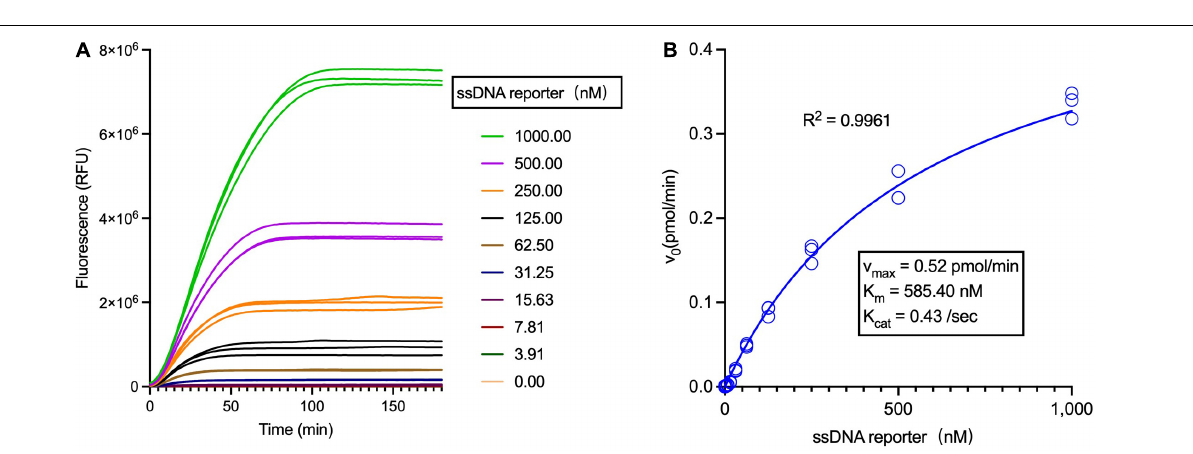
Frontiers in Microbiology |